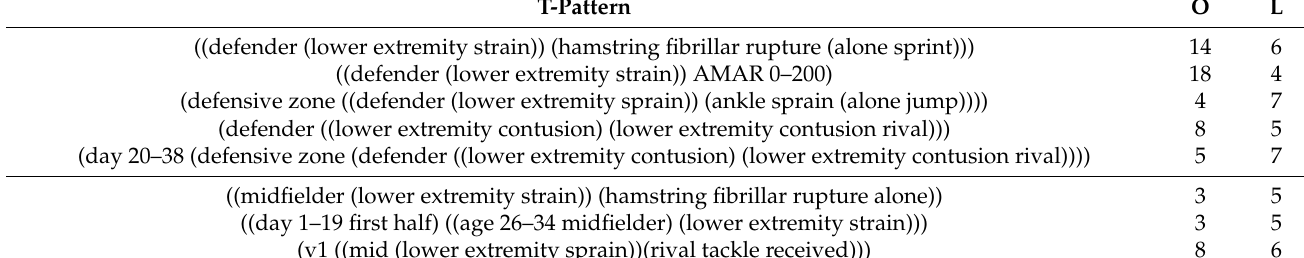
Table 3. T-patterns according to position (defender, midfielder and forward) and most frequent injury (strain, sprain and contusion).